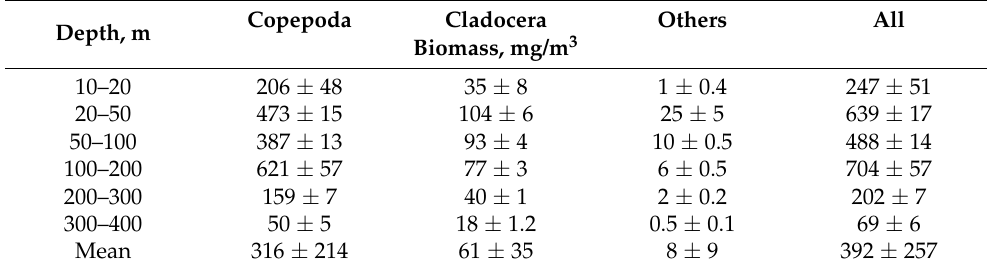
Table 8. Biomass of zooplankton in the eastern part of the Middle Caspian, May 2016.